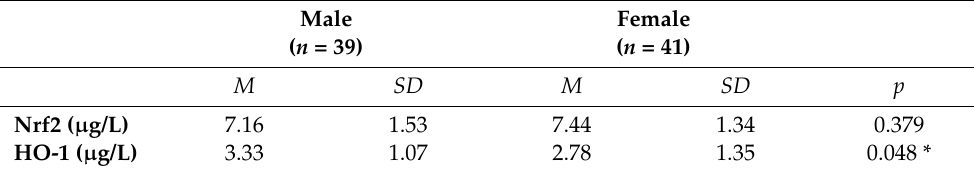
Table 5. Correlation between gender and concentration of Nrf2 and